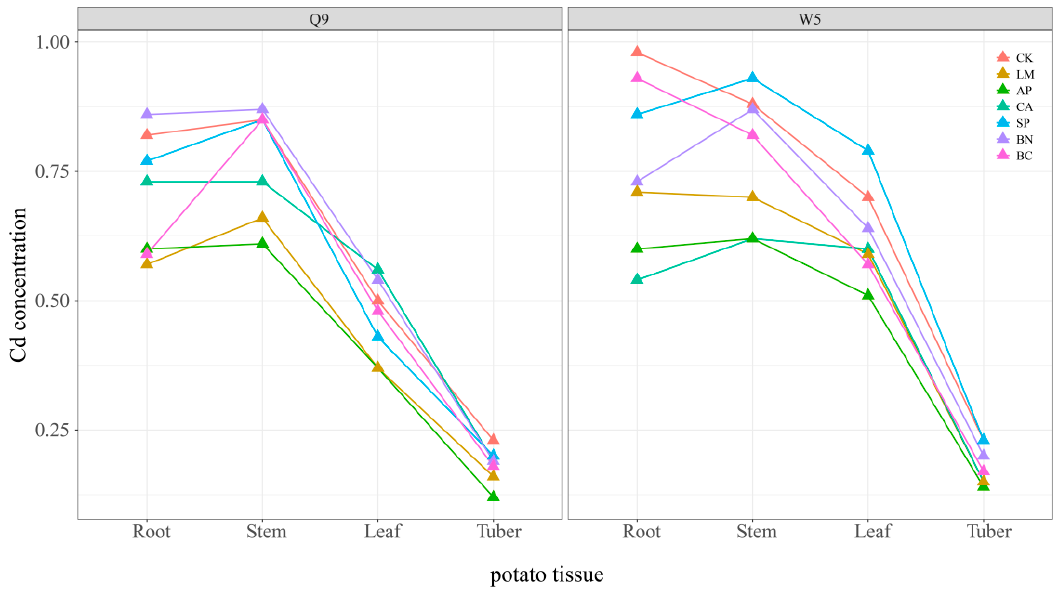
Figure 3. Effects of different passivation materials on Cd content in potato roots, stems, leaves, and tubers. For a clearer expression, we pre-logarithmically processed the data. CK, Control; LM, Lime; CA, Calcite; AP, Apatite; SP, Sepiolite; BN, Bentonite; BC, Biochar.